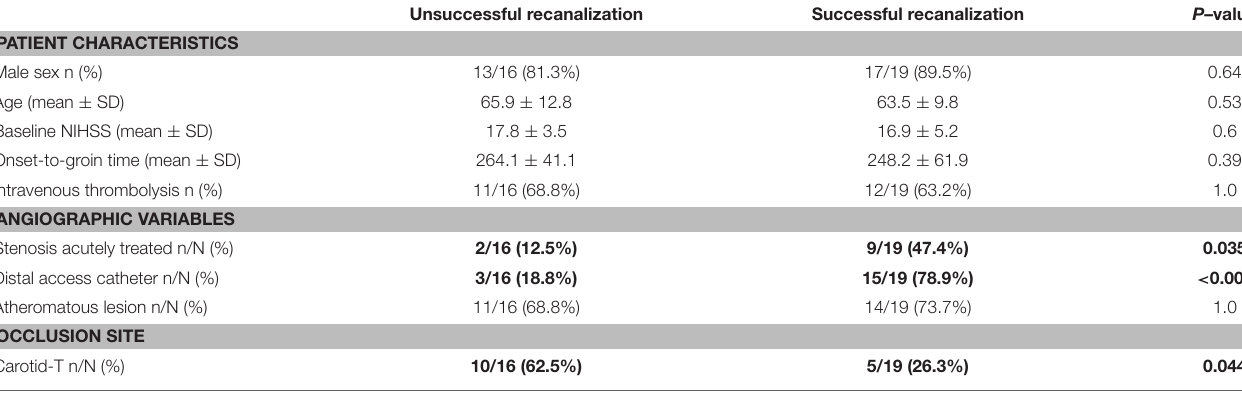
TABLE 4 | Successful vs. unsuccessful